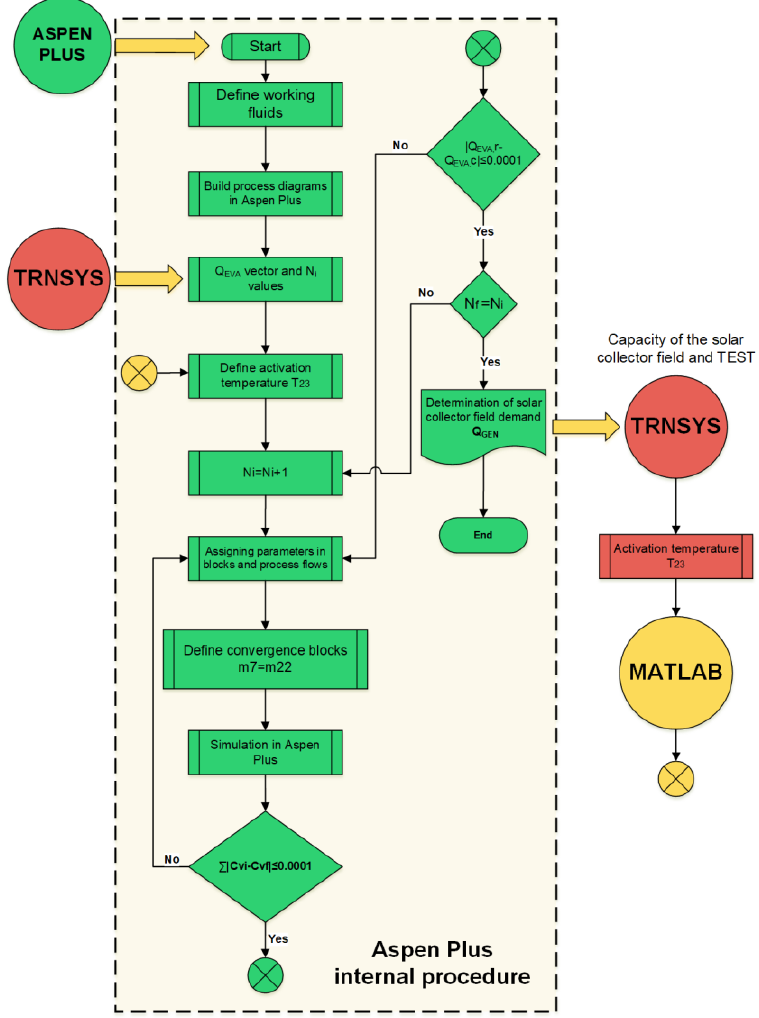
Figure 2. Methodology and software simulation procedure.